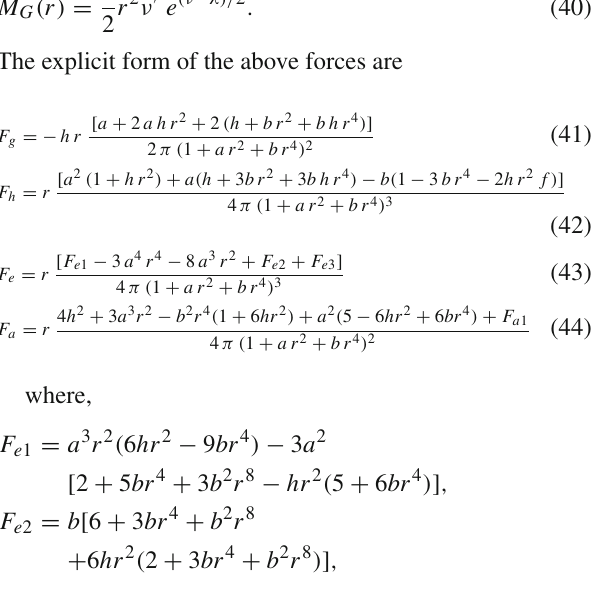
Fig. 4 Behavior of different forces versus radial coordinates r / R . For plotting of this figure, the corresponding values of arbitrary constants or parameters are displayed in Table